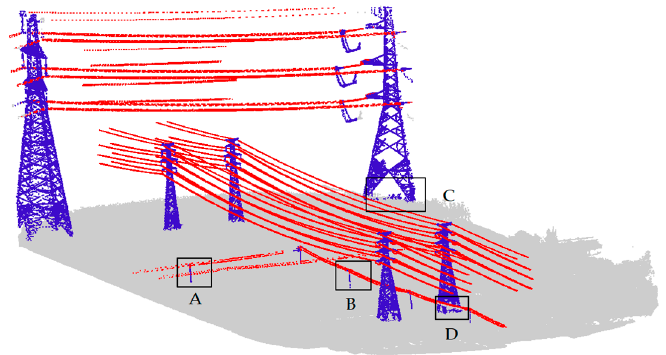
Figure 10. Final classification of the point cloud data.